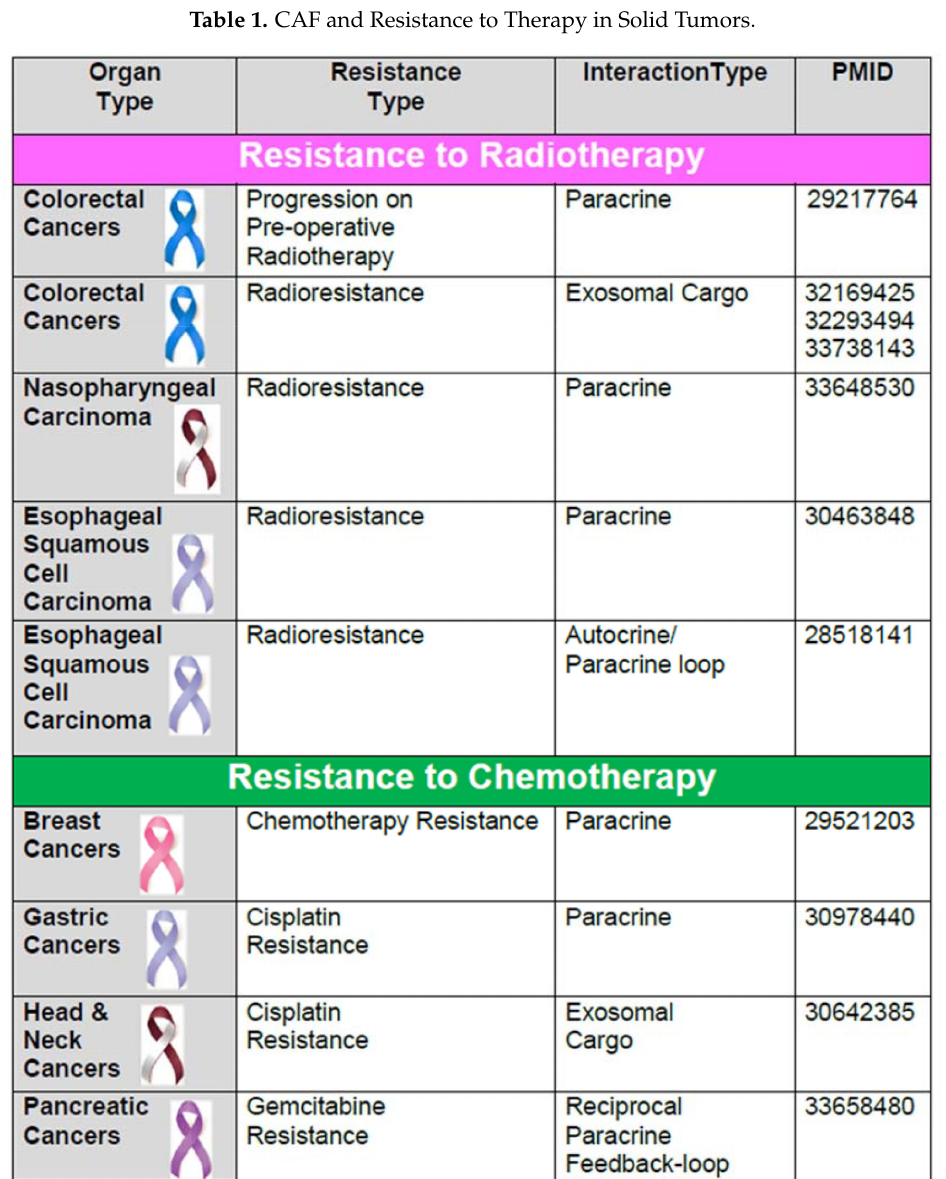
Table 1. CAF and Resistance to Therapy in Solid